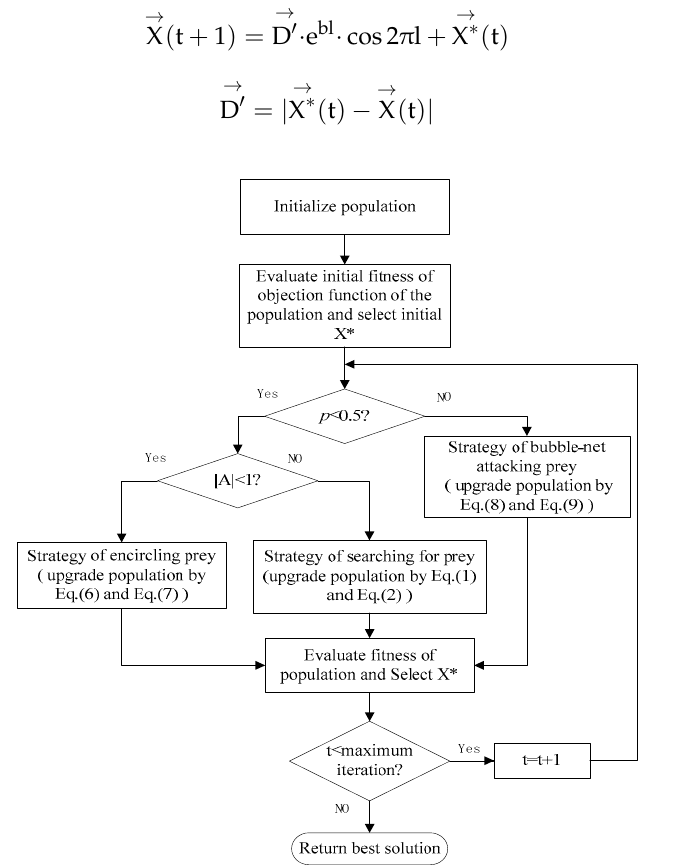
Figure 1. The flowchart of WOA.